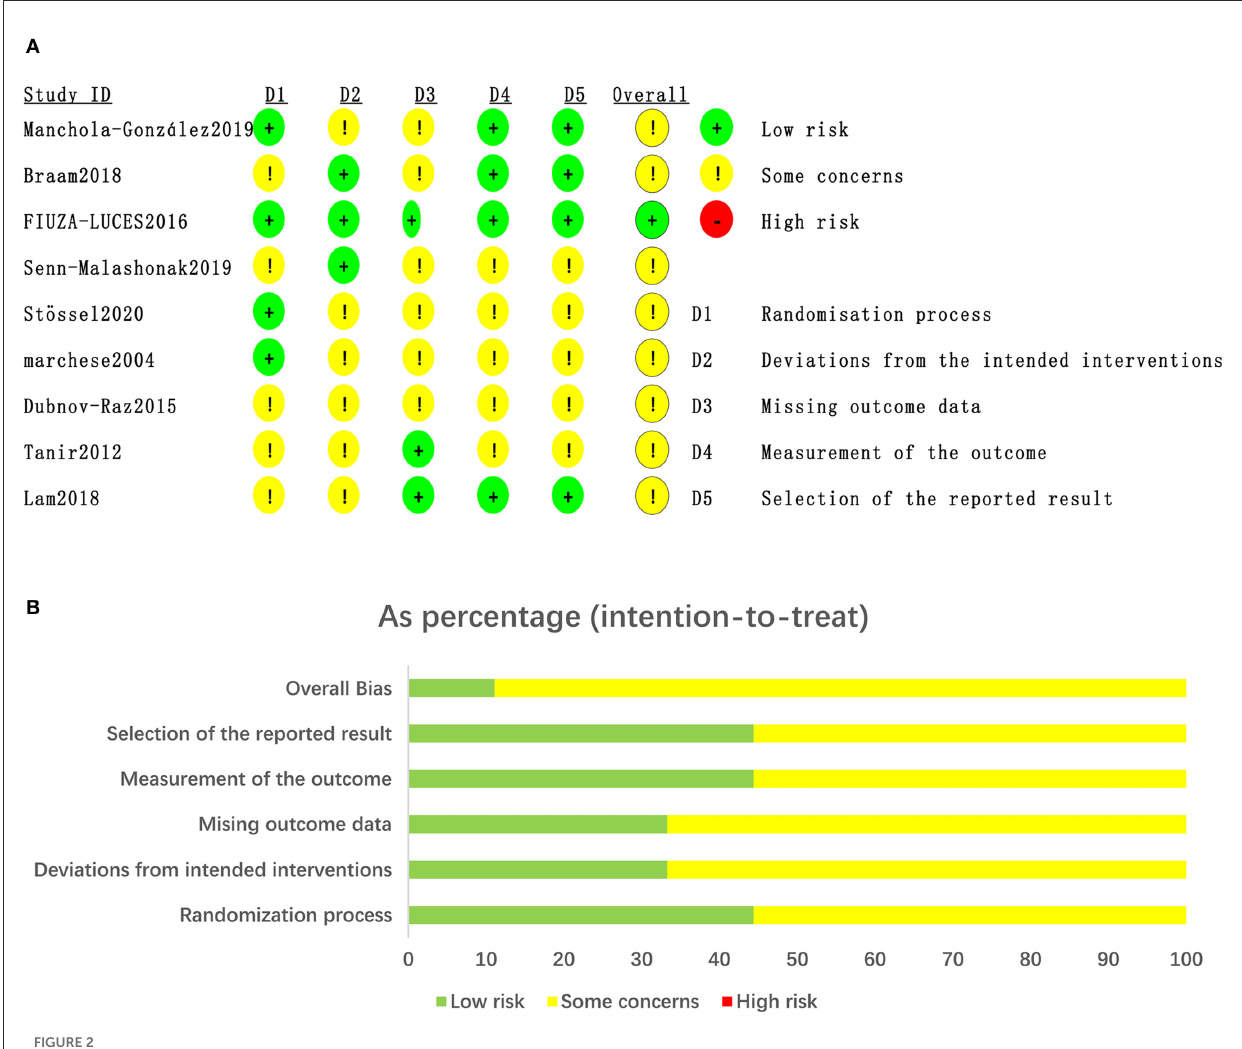
to the different measurement tools used, the SMD was